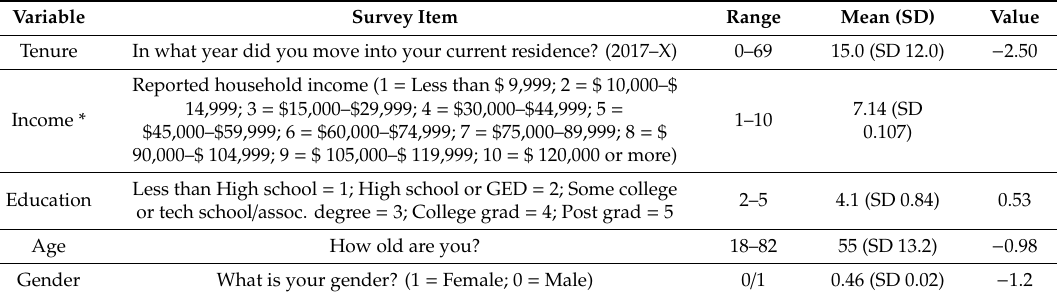
Table 2. Personal characteristics of survey